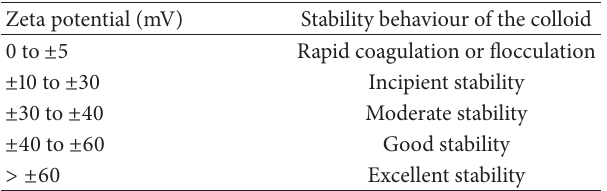
Table 3: Stability behaviour of colloids at different zeta potential values.